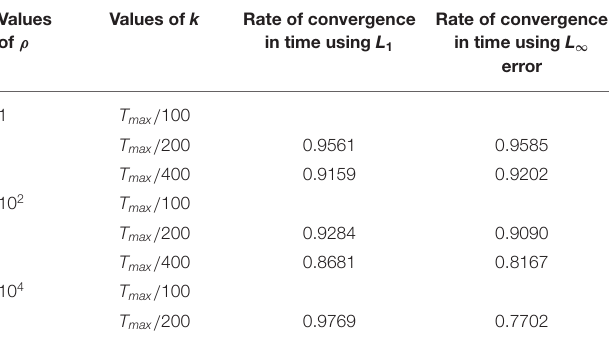
TABLE 5 | Rate of convergence in time for NSFD using different values of ρ at time, T max 2.5 10 − 3 with h 0.01. = × =